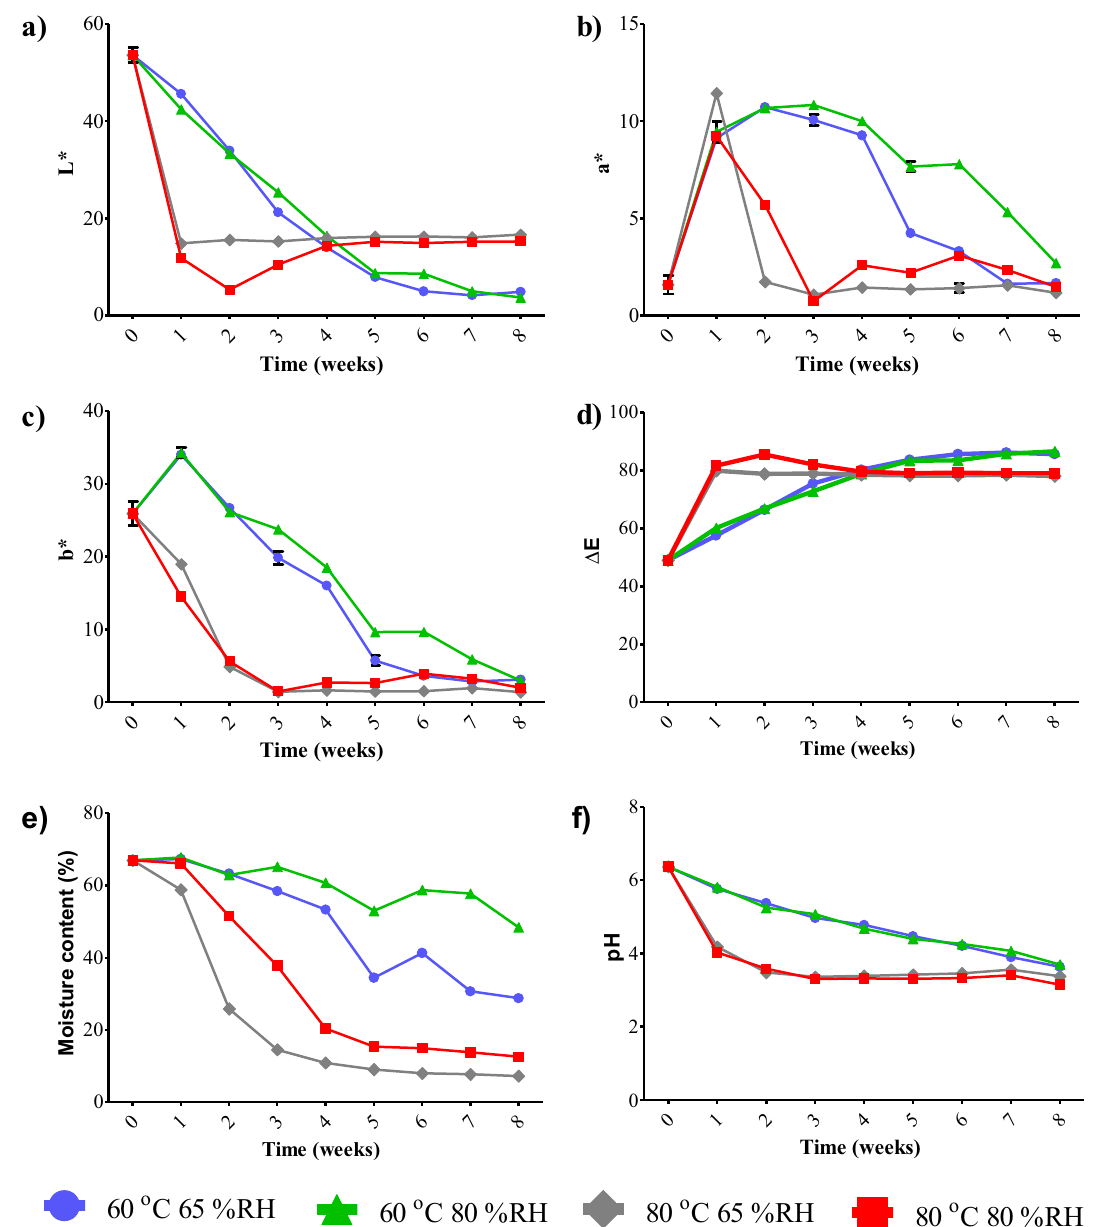
Figure 3. Colour of black garlic after different thermal processes at various temperatures and relative humidities: ( a ) L*, ( b ) a*, ( c ) b*, ( d ) ∆E, ( e ) moisture content and ( f ) pH; error bars represent standard deviations of the mean (n =